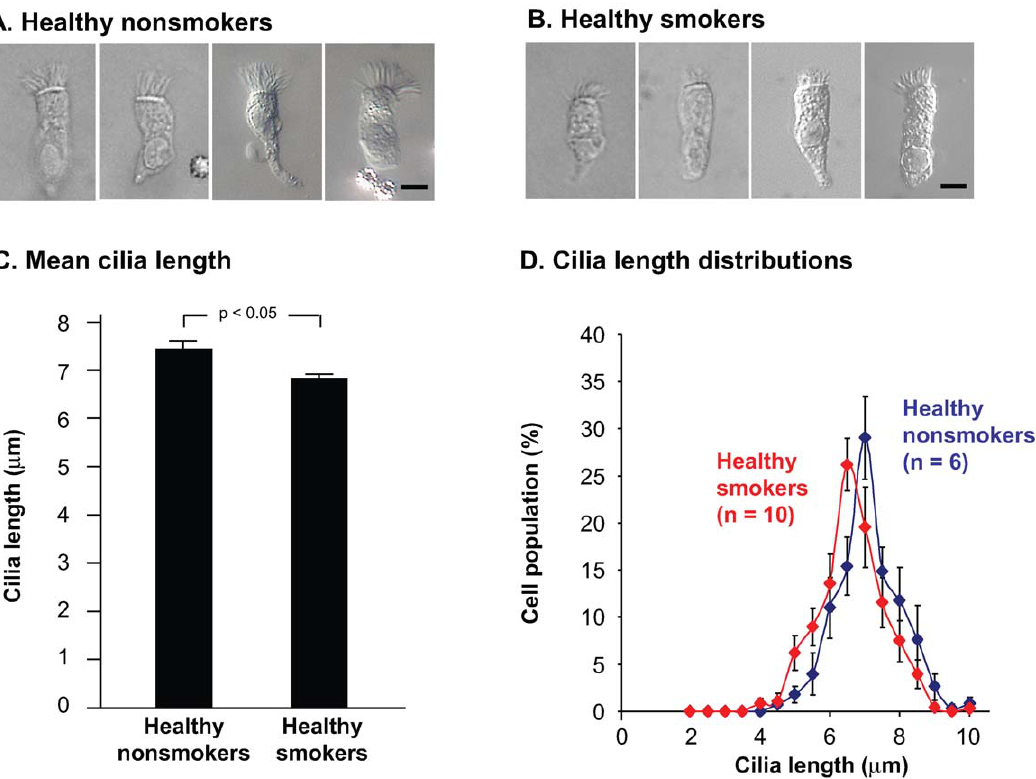
Figure4. Cilialengthinnormal smokersandnonsmokersmeasuredinunfixed, hydratedcells. Freshlyisolatedsuspensions of airwayepithelial cells were added to coverslip chambers and imaged using differential interference contrast microscopy. (A) Ciliated airway epithelial cell morphology in normal nonsmokers. Bar =10 m. (B) Ciliated airway epithelial cell morphology in normal smokers. Bar =10 m. (C) Mean cilia length within the study populations. Shown are the mean standard error of cilia lengths for nonsmokers (n=6) and smokers (n=10). Between 17 and 46 individual measurements were made per study individual (median =24.5). (D) Distribution of cilia lengths in airway epithelial cells from normal nonsmokers and normal smokers. Distributions were constructed by creating histograms from 0.5 micron bins and then equally weighting each study individual.